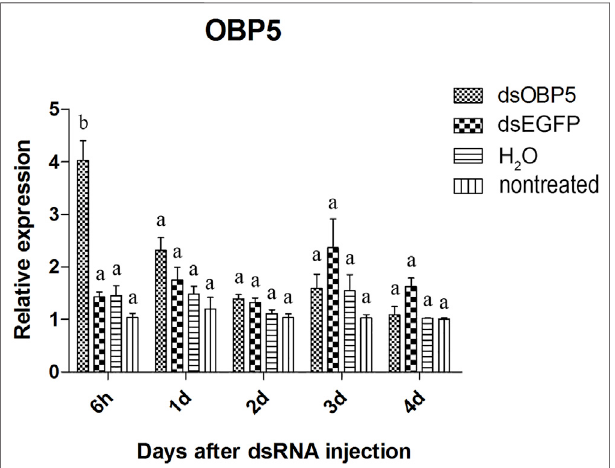
FIGURE 3 | Relative expression of OBP5 in EAB adults after dsRNA injection. Relative expression of OBP5 by RT-qPCR assay was evaluated 6h, 1,2,3and4 daysafterinjecting3 µgdsRNA. TEF-1 α wasusedasareference gene for normalization. Means ± SE (n = 4) are shown. Statistical analyses were performed using ANOVA/LSD method at p < 0.05 for comparison among treatments. Statistical differences are shown by different letters between different treatments at the same time point.